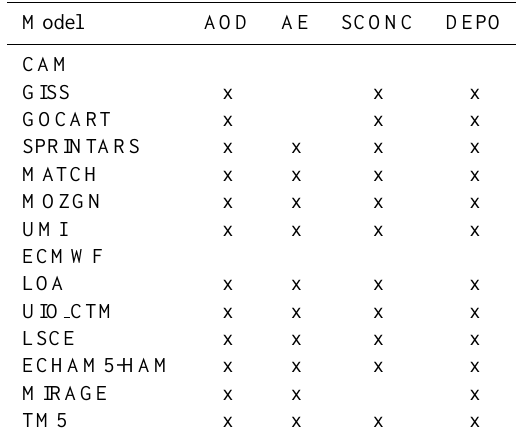
Table 2. Models used to compute the AeroCom median for each variable are indicated by an x. The variables are aerosol optical depth at 550nm (AOD), Angstr¨om exponent (AE), dust surface con- centration (SCONC) and dust total deposition